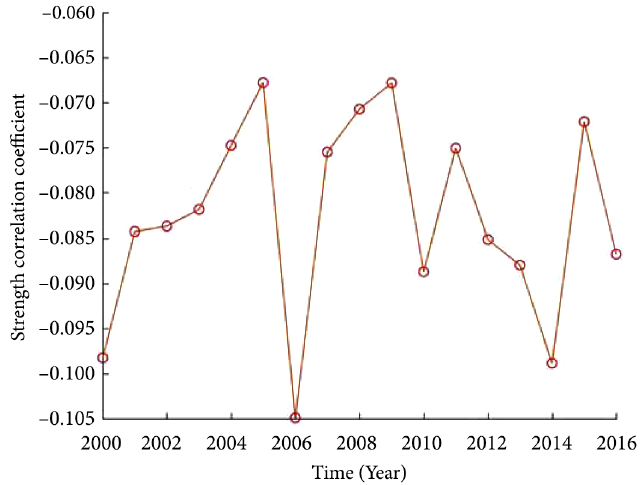
Figure 8. Evolution of node strength correlation coefficient from 2000 to